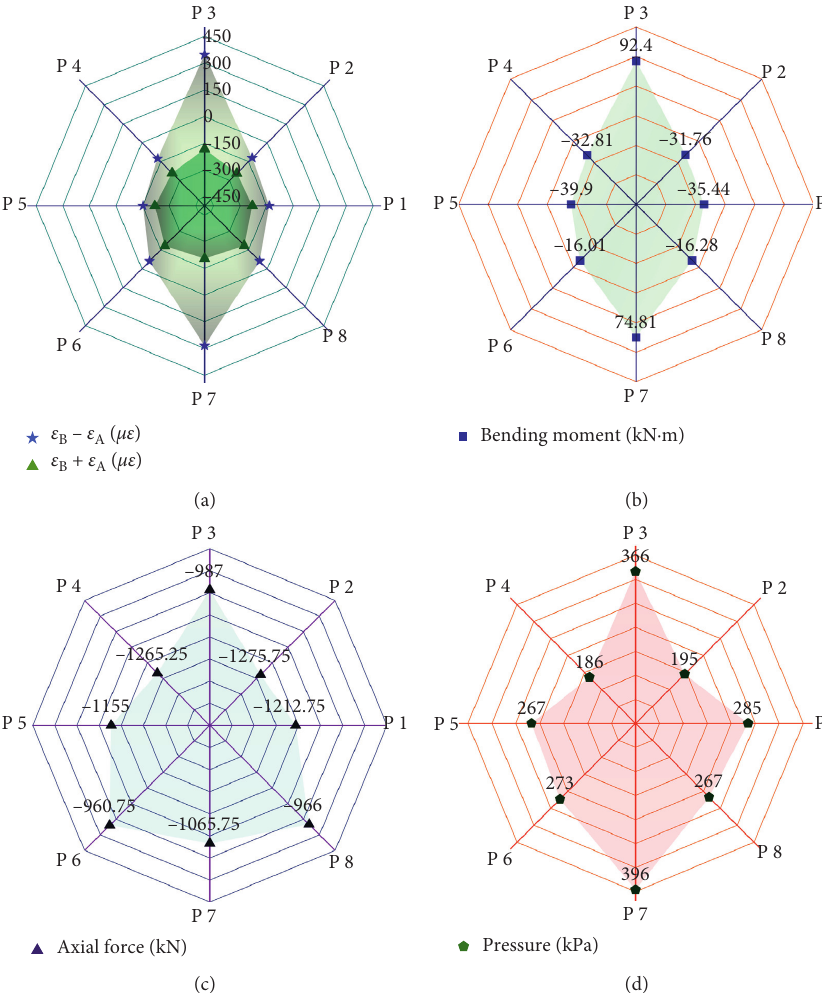
Figure 7: Test results. (a) Sum and difference in strain. (b) Moment. (c) Axial force. (d) Earth